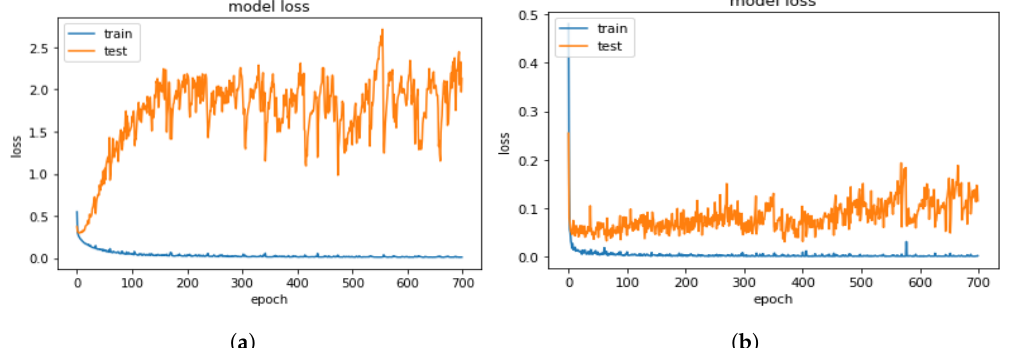
Figure 8. Comparison between history models loss for 11,814 samples and 18,526 samples. ( a ) Loss for 11,814 samples. ( b ) Loss for